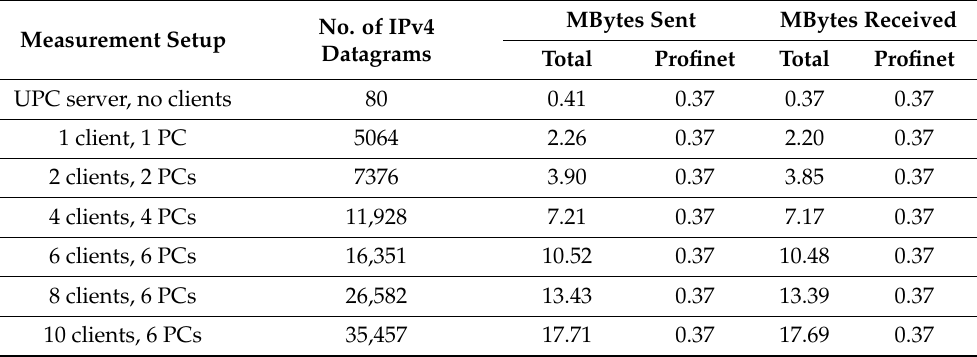
Table 4. The number of IPv4 datagrams and the size of the data that was sent and received depending on the number of OPC UA clients.